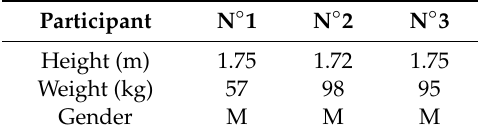
Table 2. Anthropometric data of the participants of the present